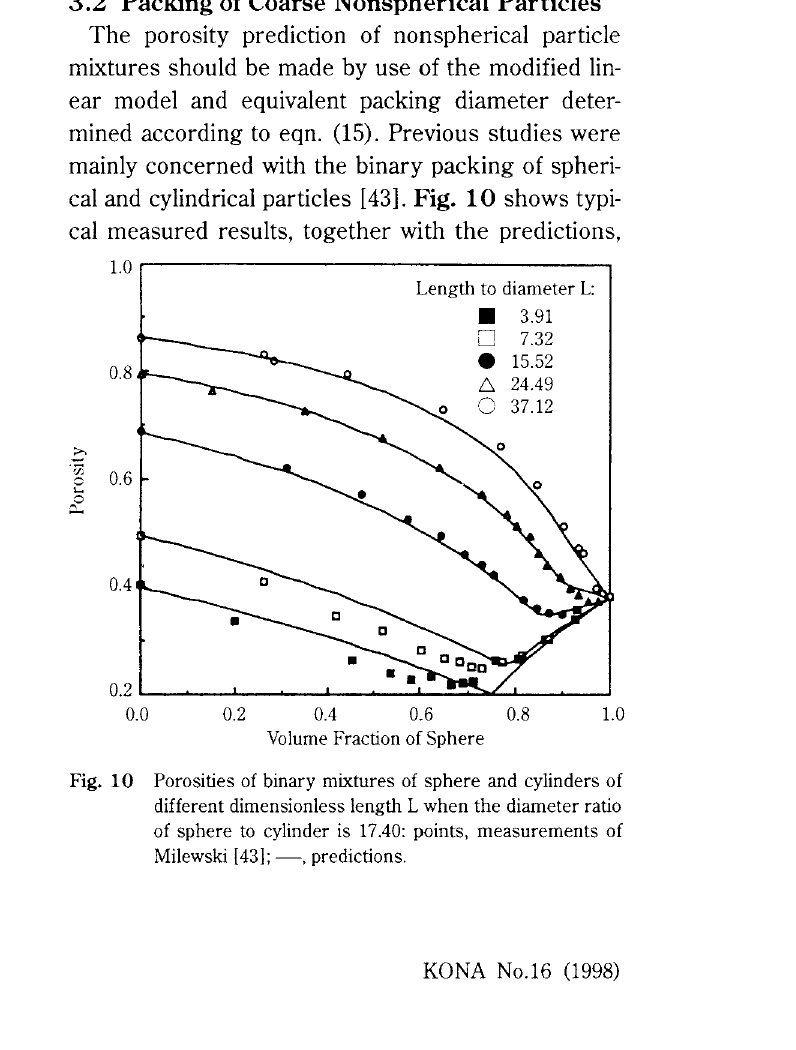
Fig. 9 Porosity of ternary mixtures of the log-normal distribu tion with the dimensionless median of the central compo nent equal to unity (Eo=0.40 and <Jg=2.0).